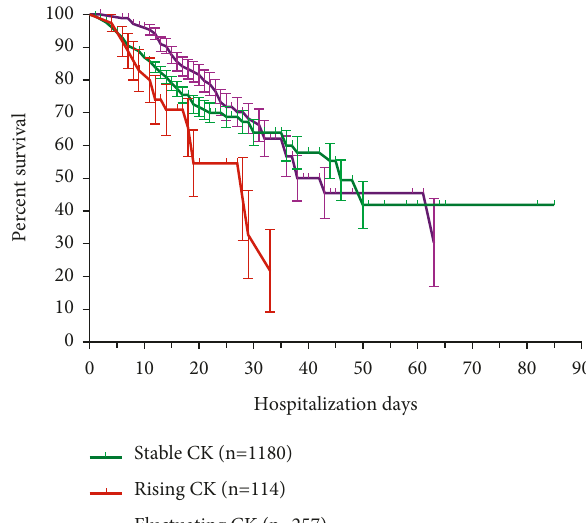
Figure 4: Kaplan–Meier curves for in-hospital mortality among COVID-19 subjects with rising CK, stable CK, and fluctuating CK